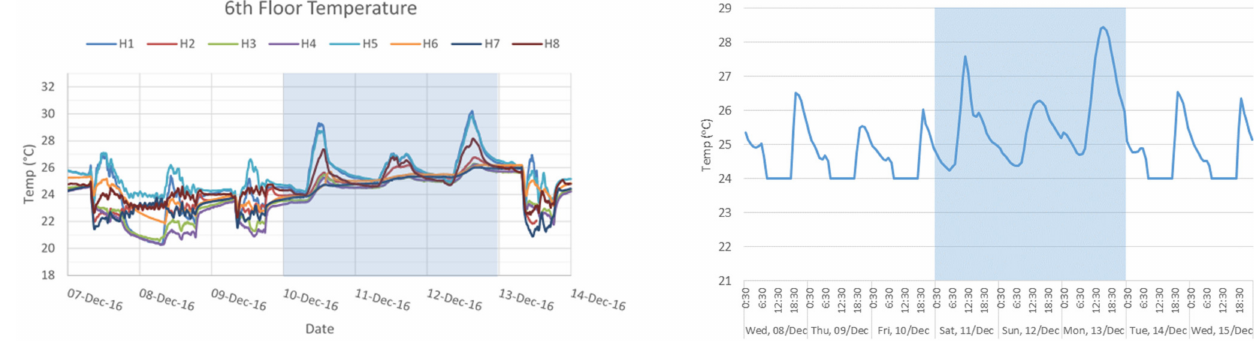
Figure 6. Indoor air temperature for 7 days in level 6 (field measurements on the left and simulation results on the right )